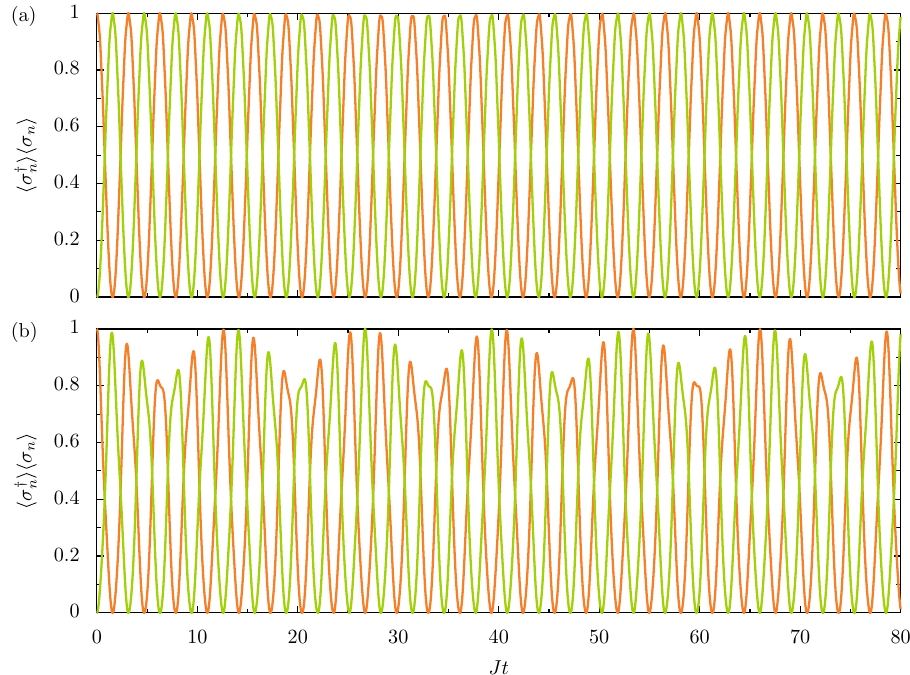
σ n σ † as a function of time t for the n -th 2LS, n (cid:30)(cid:31) (cid:30) (cid:31) 1 . Green lines: n 2 . = = 10 J . Panel ( b ): the ultrastrong =